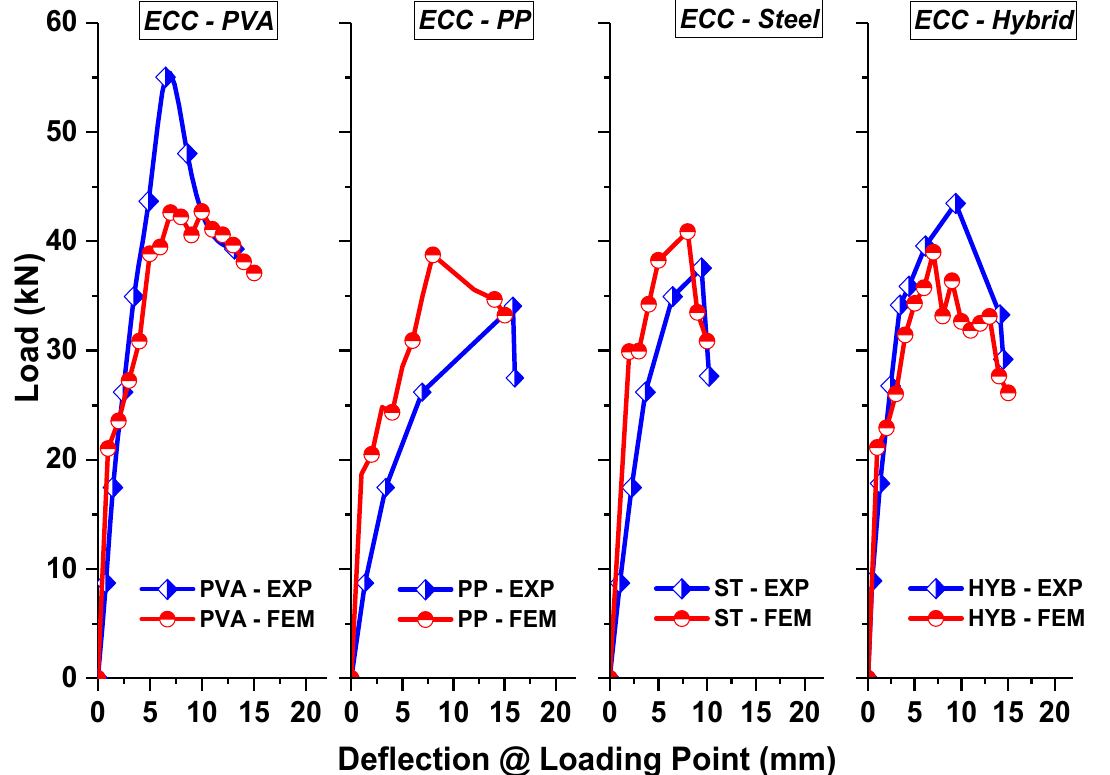
Figure 6. Load–deflection comparison for ECC specimens.